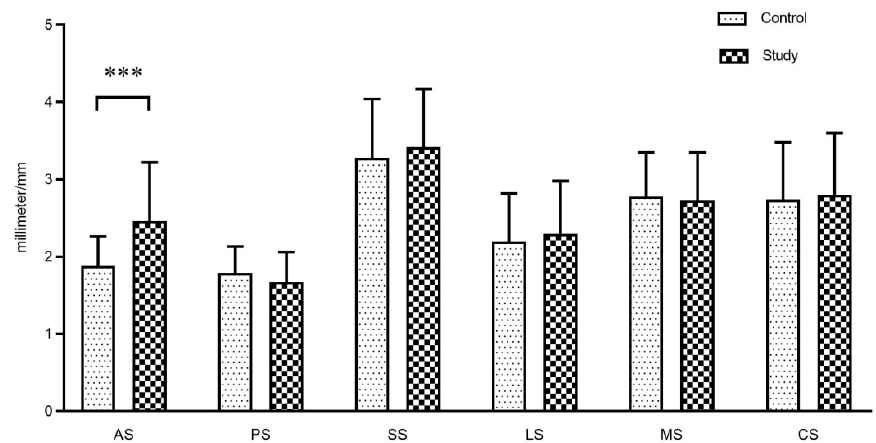
Figure 7. The size of the joint space between the study group and the control group. AS: anterior space, PS: posterior space, SS: superior space, LS: lateral space, MS: medial space, CS: central space. Results are shown as mean ± SD. *** p = 0.000.